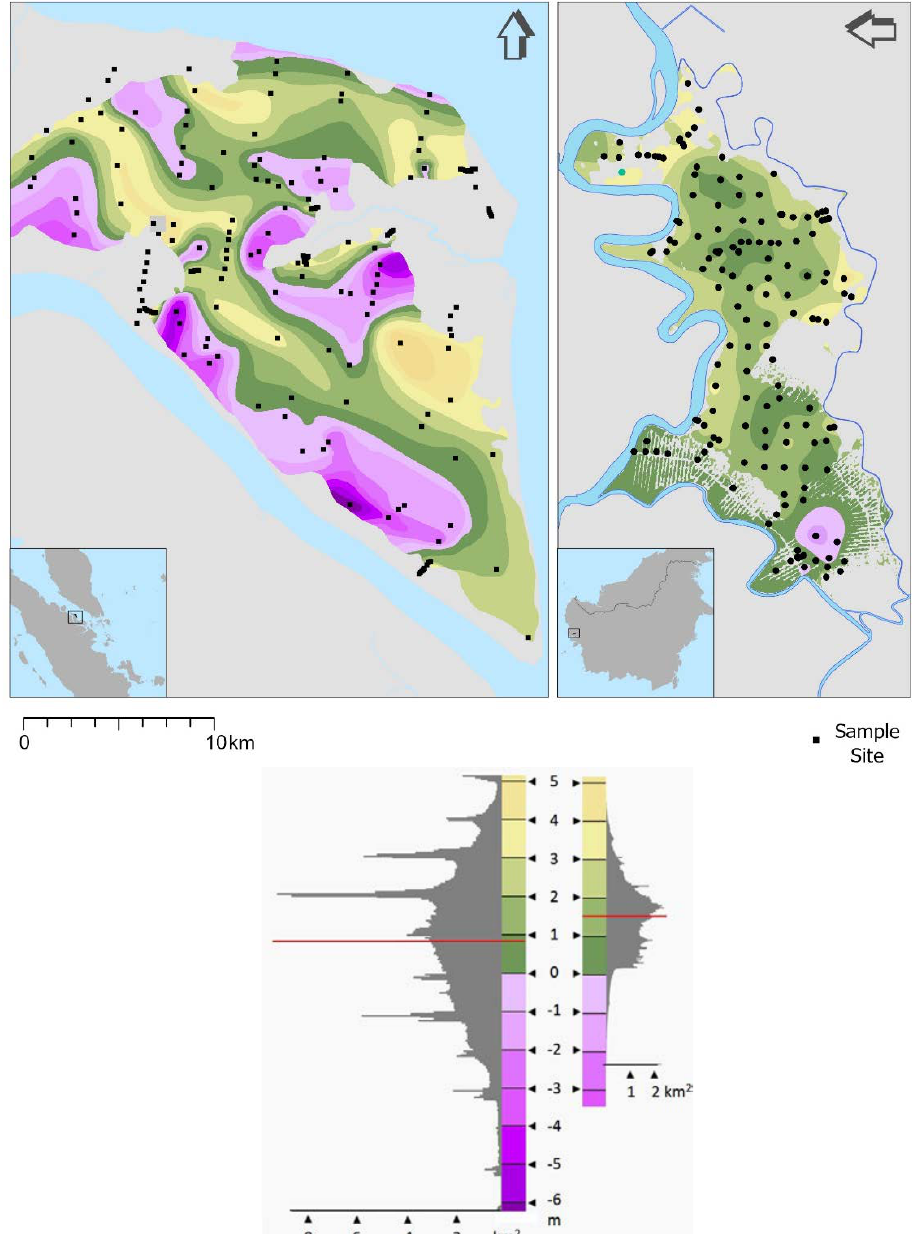
Figure 4. Soil sample points, peat base elevation (m), peat extent at each base elevation level (km 2 ) and mean peat base elevation (red line) at Bengkalis (left) and Kubu Raya (right). At Bengkalis, peaks in the frequency of peat base area at distinct intervals may indicate extensive mud flats on the pre-deposition surface due to coastal erosion and sea level